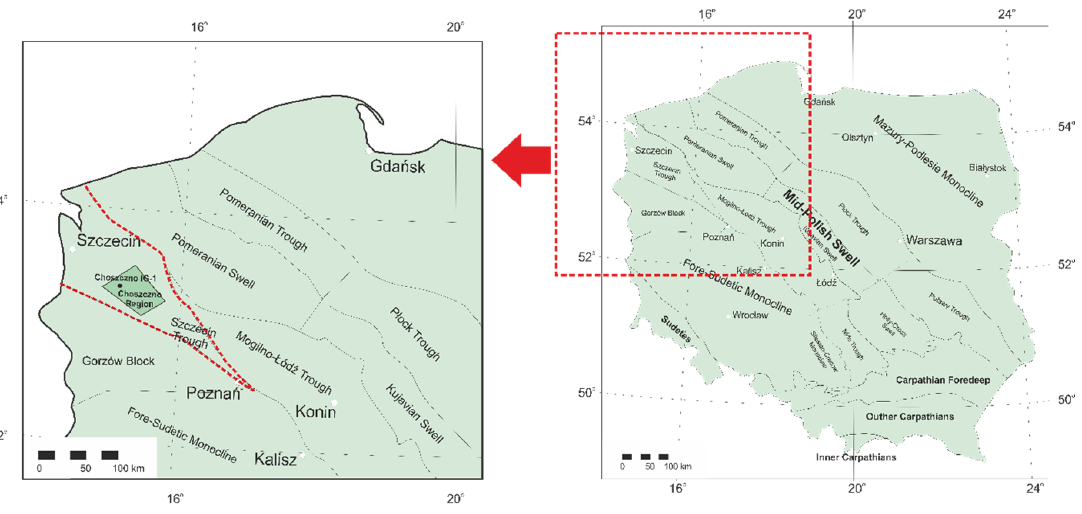
Figure 1. Location of the study area on the background map of the main tectonic units of Poland on the sub-Cenozoic surface [54].